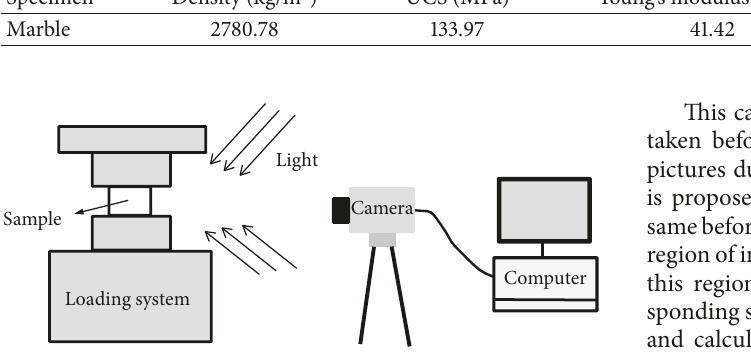
Figure 2: The schematic diagram of the image acquisition system: loading system, light source, a digital camera, and a